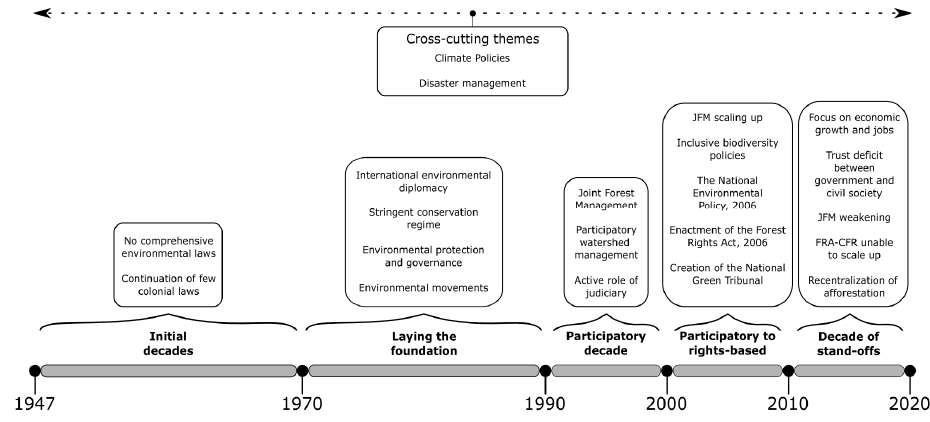
Figure 2. Evolution of India’s environmental policy [38].